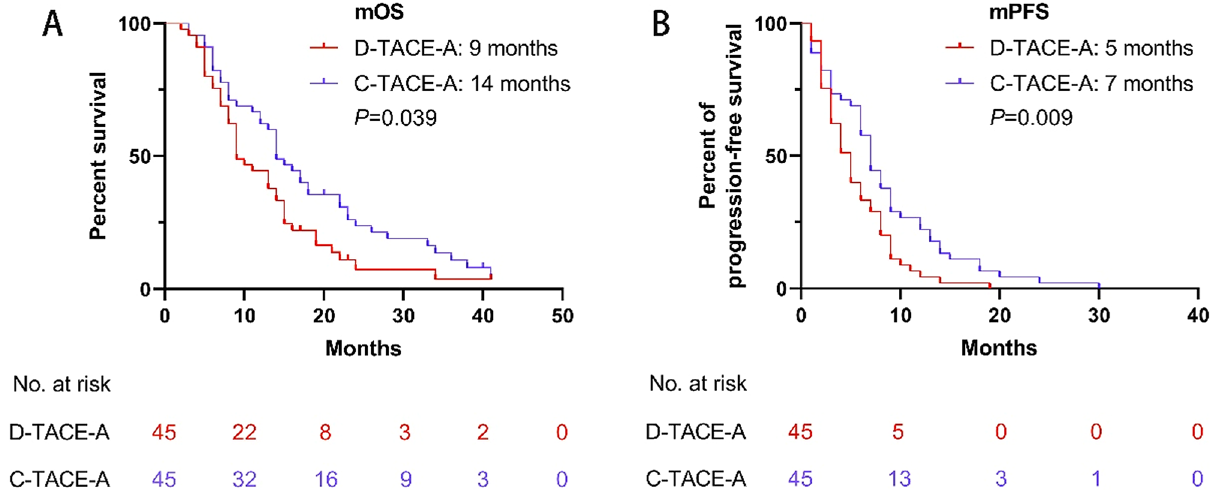
Figure 3. Kaplan–Meier curves of overall survival and progression-free survival in the patients after PSM. ( A ) Kaplan–Meier curve for overall survival; ( B ) Kaplan–Meier curve for progression-free survival.